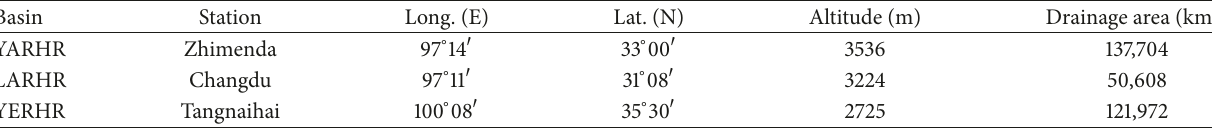
Table 2: Detailed information of the three hydrological stations in the TRHR.